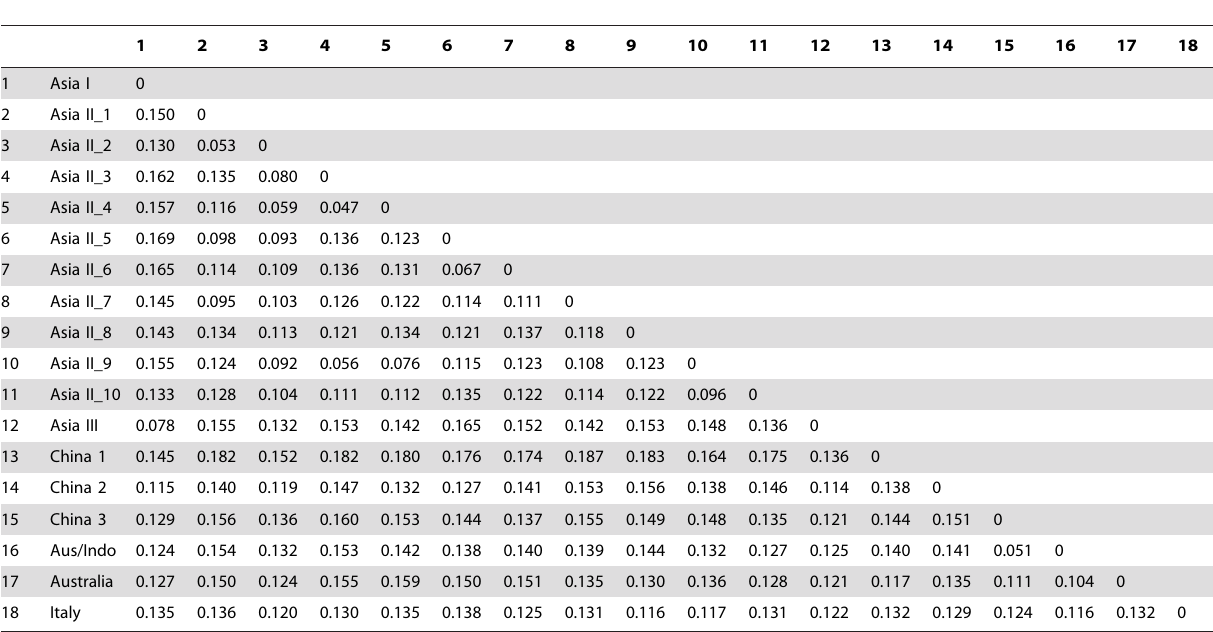
Table 2. Mean Kimura two-parameter genetic distances between putative species belonging to the Asia